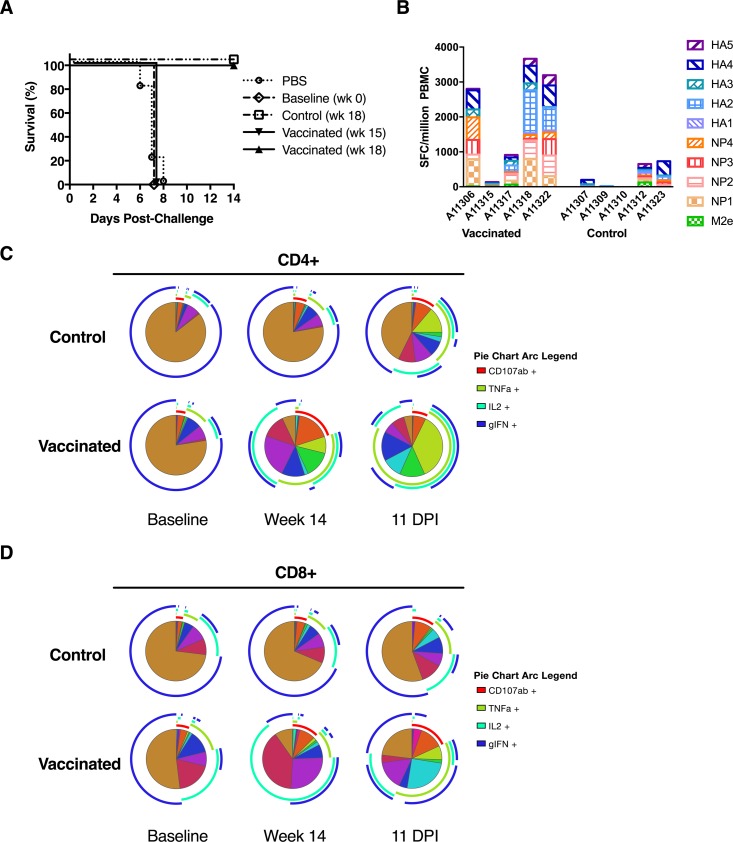
Protection from influenza is mediated by T cell responses and not antibody responses.A) Passive transfer in mice of purified IgG from vaccinated and control macaques followed by influenza challenge with 10 MLD50 CA09 virus. Survival of BALB/c mice (n = 10 per group) passively immunized (intraperitoneally) with 25 mg IgG 24 hrs before challenge with a lethal dose of CA09 influenza virus. B) Sum of responses of vaccinated animals to influenza peptide pools corresponding to subsets of HA, NP and M2e at 3 weeks post challenge (week 18) p<0.05. Spice graphs displaying cumulative polyfunctional C) CD4+ and D) CD8+ T cell responses following stimulation with HA, NP, and M2e peptide pools at baseline (week 0), post vaccination (week 14) and 11 days post infection (DPI) (week 16+4 days). The pie charts summarize the cumulative CD4+ and CD8+ T cell responses to the various effector functions as ether mono-or poly-functional responses.